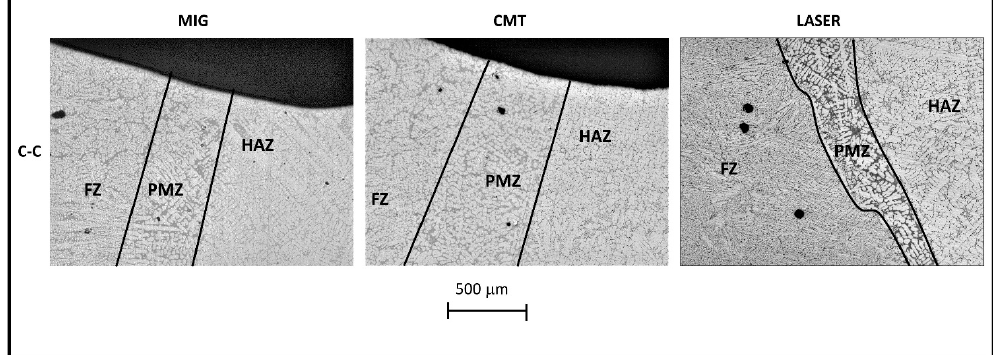
Figure 8. Macrostructures of the interface between the HAZ (heat-affected zone), PMZ (partially molten zone), and FZ (fusion zone) in the Cast-Cast combination (C-C), Keller etch, 50×.